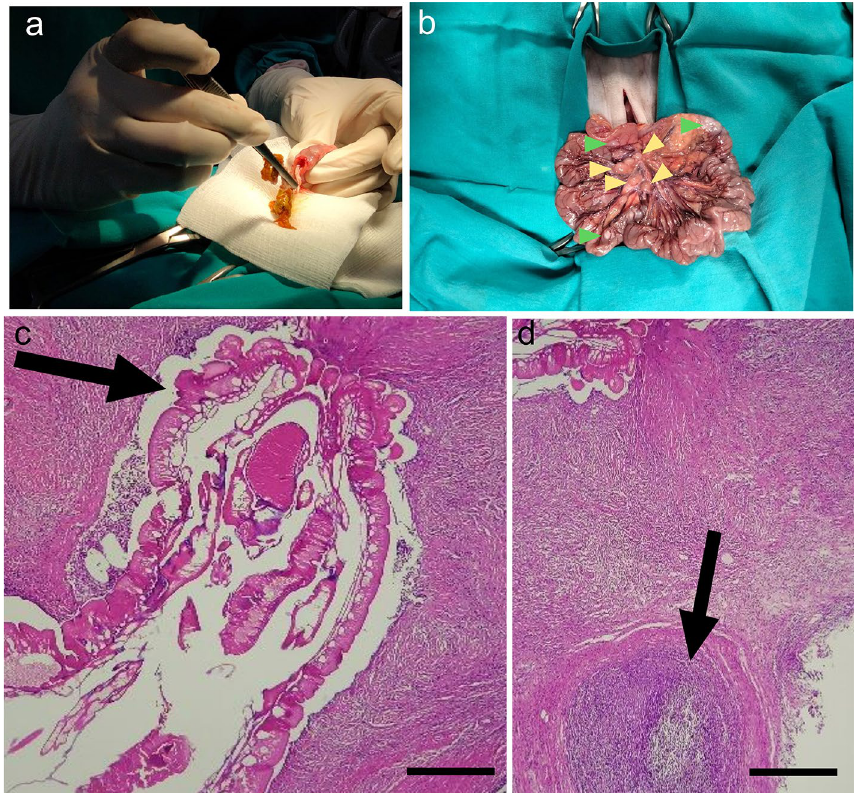
Figure 1. Macroscopic and microscopic findings of intestinal lesions induced by P. elegans in S. o. citrinellus . ( a ) Extraction of an adult specimen during intestinal surgery. ( b ) Macroscopic appearance of the large bowel showing enlarged lymph nodes (yellow arrowheads) and nodules induced by the worms (green arrowheads). ( c ) Histopathological staining of P. elegans worms penetrating the intestinal muscular wall and inducing a severe pyogranulomatous reaction (Bar: 1.5 mm). ( d ) Inflammatory foci in the outer muscle layer and serosa of the intestine consisting of degenerated parasites surrounded by macrophages, neutrophils, eosinophils, fibroblasts and lymphocytes (Bar: 1.7